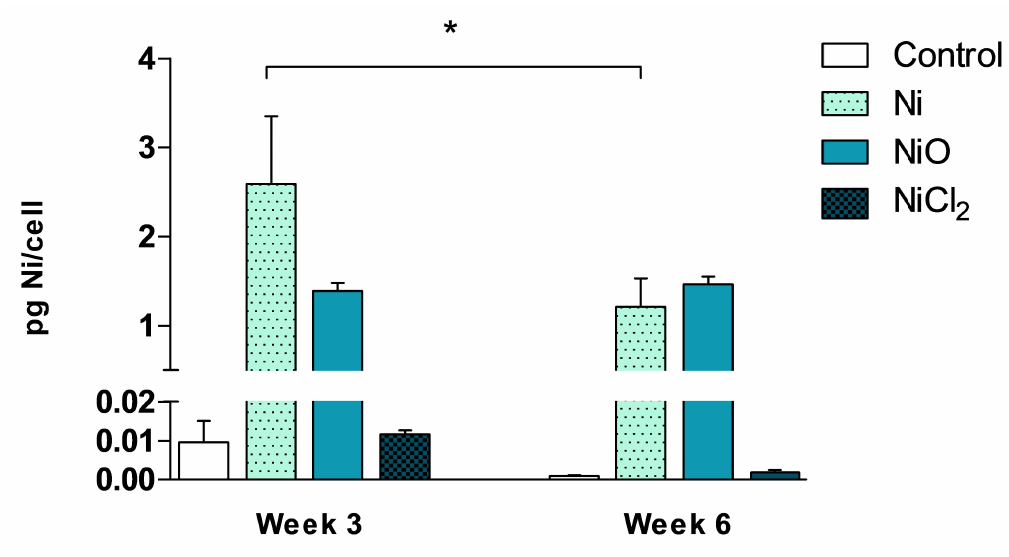
Figure 3. Cellular nickel content was quantified by ICP-MS after 3 and 6 weeks of exposure. Results and expressed as pg Ni / cell and are presented as mean values ± S.D. ( n = 3). Significant results are indicated with asterisks (* p -value <